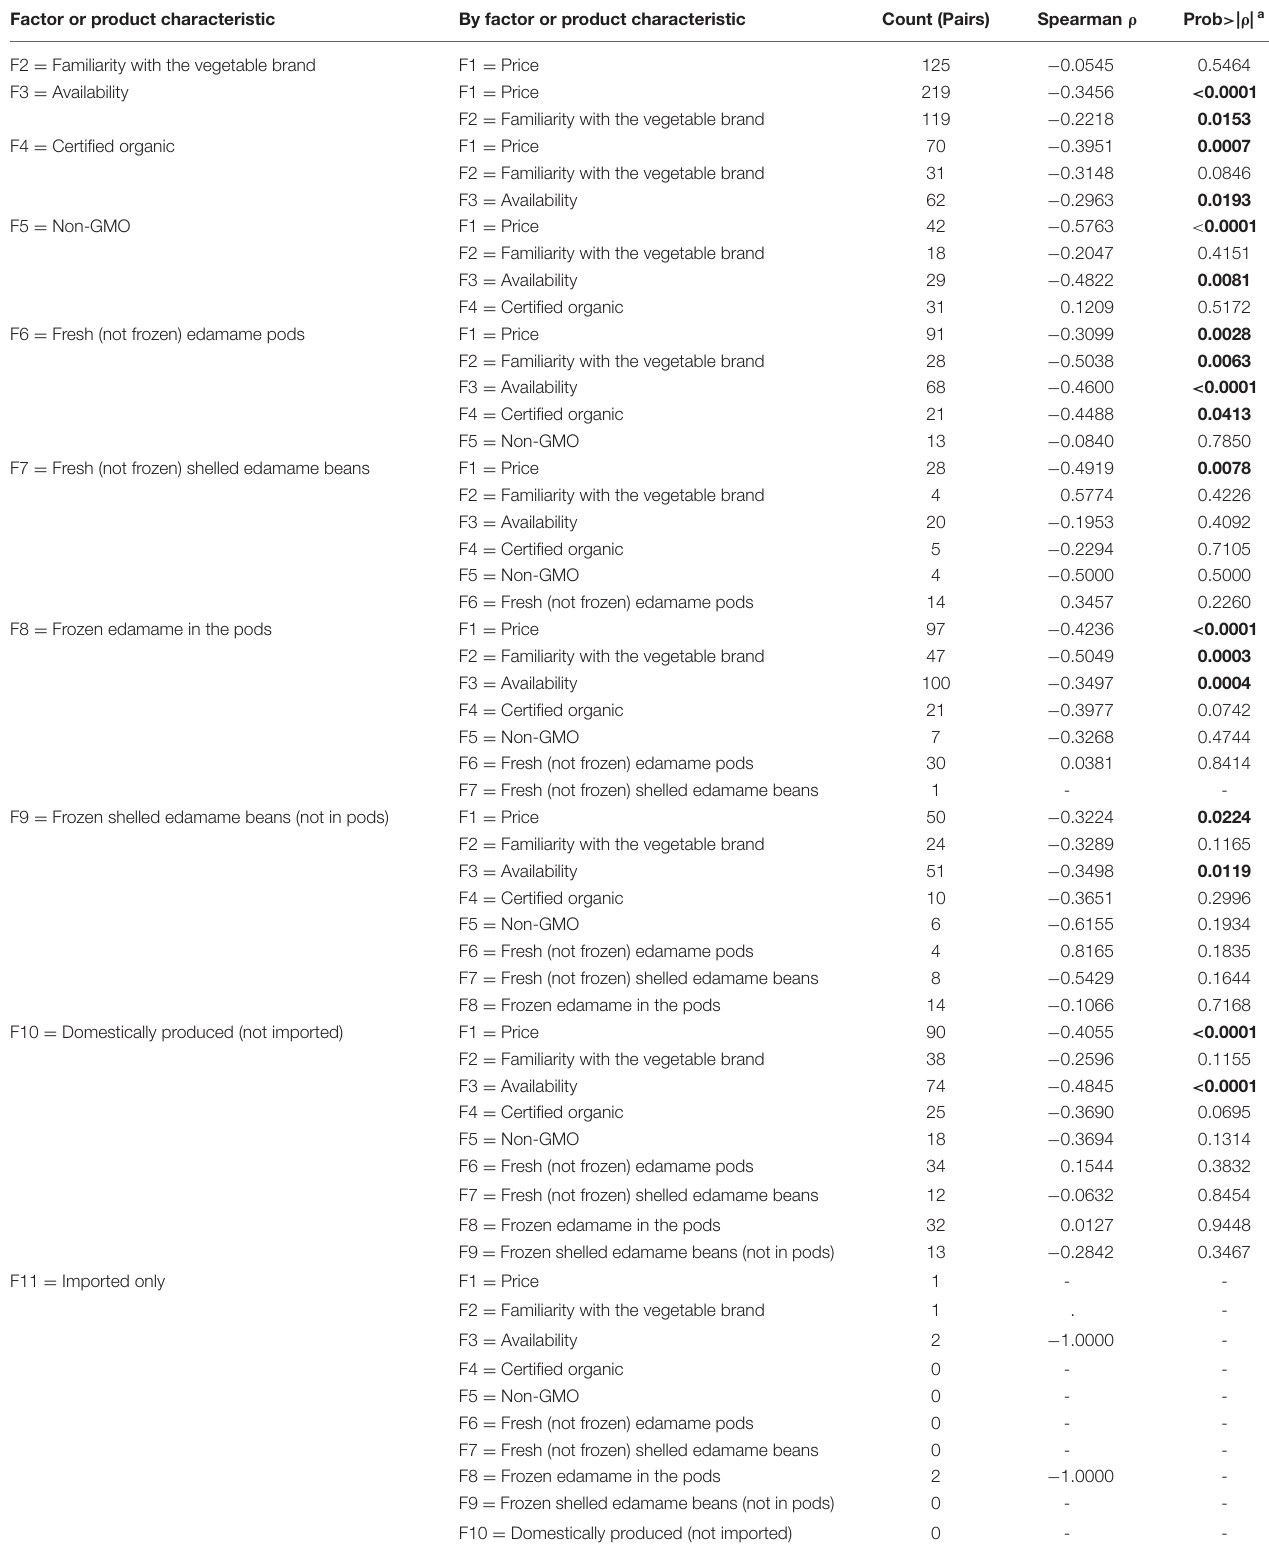
TABLE 5 | Correlation between edamame purchase factors or product characteristics ranked by consumers in the U.S. Factor or product